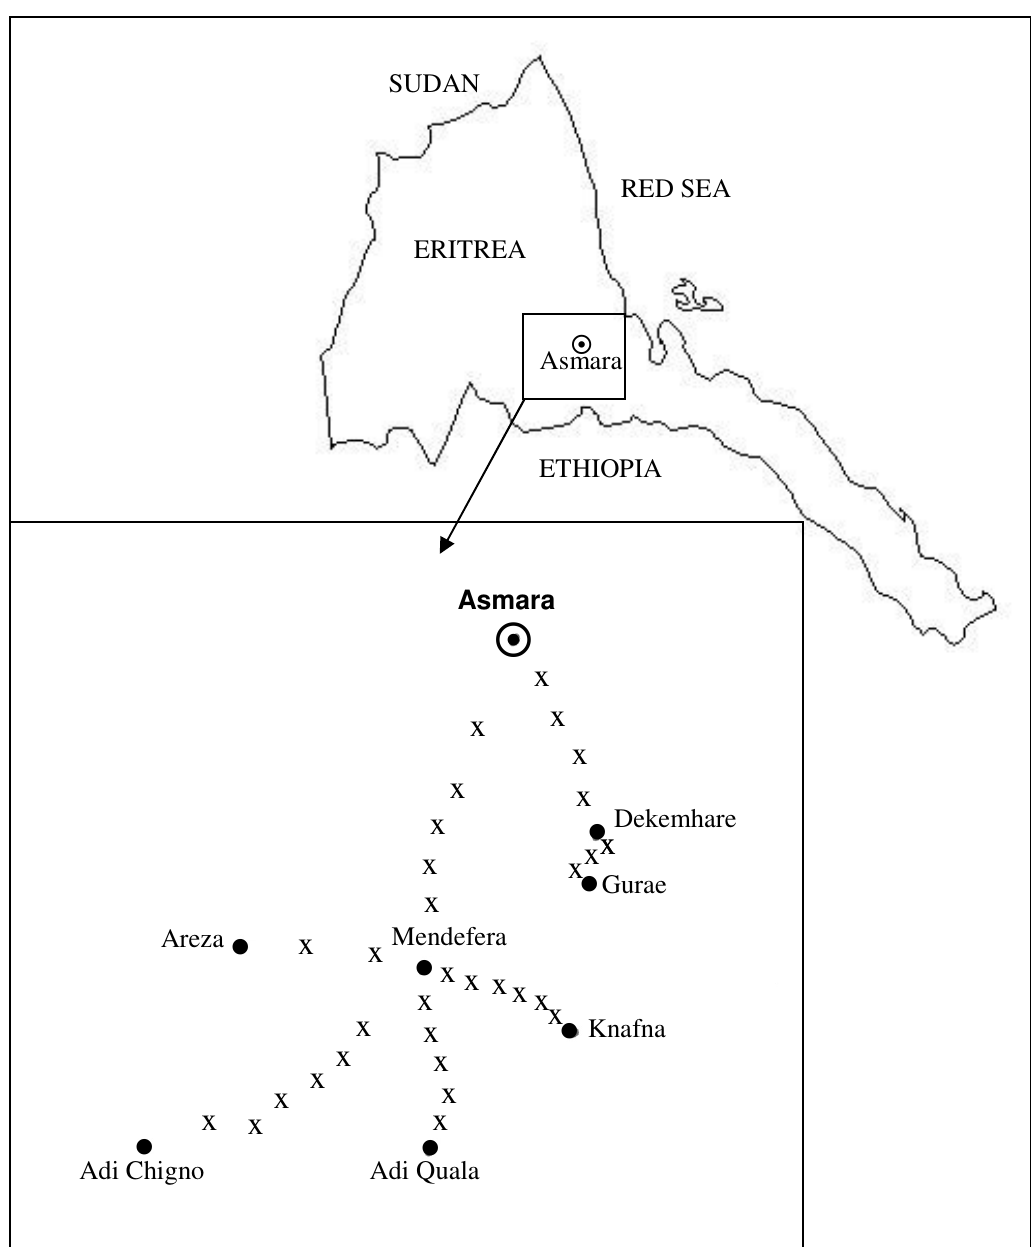
Fig. 1. Map of Eritrea showing the location of chickpea fi elds (x) surveyed in November 13–22,